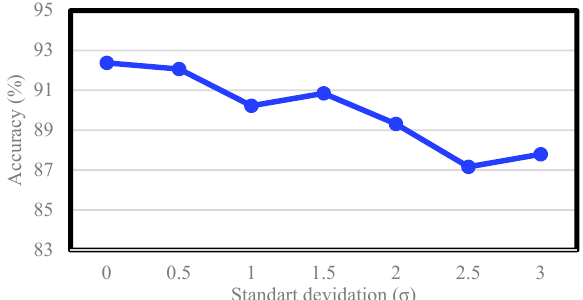
Figure 10. Accuracy of LMED-CF according to the noise standard deviation.